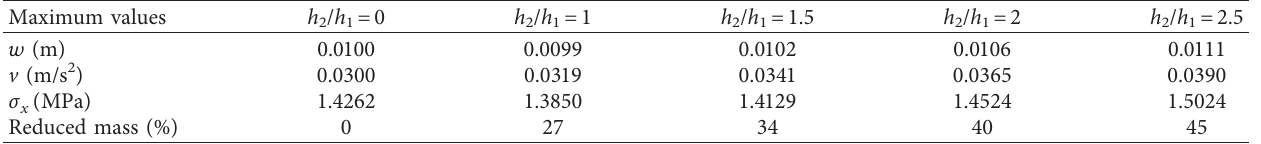
Figure 7: Dynamic deflections of the centre point of the plate versus time for different h v versus time, and (c) stress σ x versus time. Table 5: Maximum deflections, velocities, and stress of the plate central